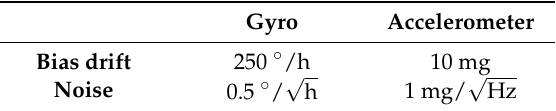
Table 2. The parameters of the MEMS IMU. Gyro Accelerometer √ 1 mg/